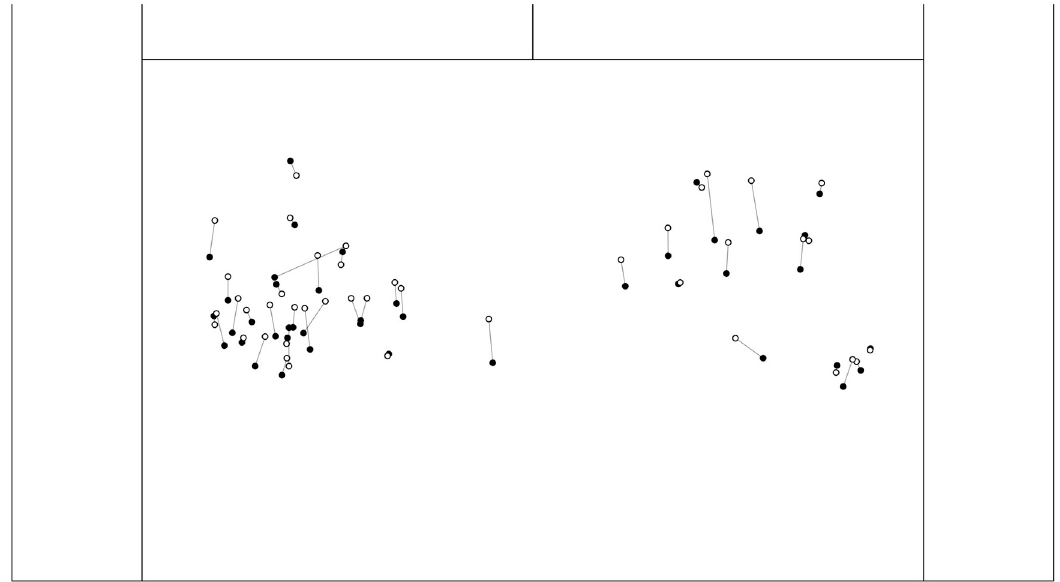
Fig 3. The influence of grunt intensity on judgments of the ball’s landing position on the court. Solid black dots = high intensity grunt; white dots = low intensity grunt.